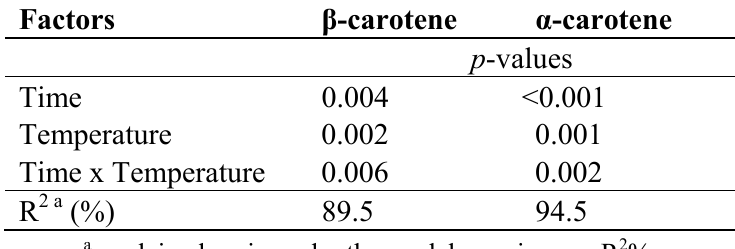
Table 2. P -values for the effect of time and temperature of extraction and their interaction on the yield α , β -carotenes from response surface regression.